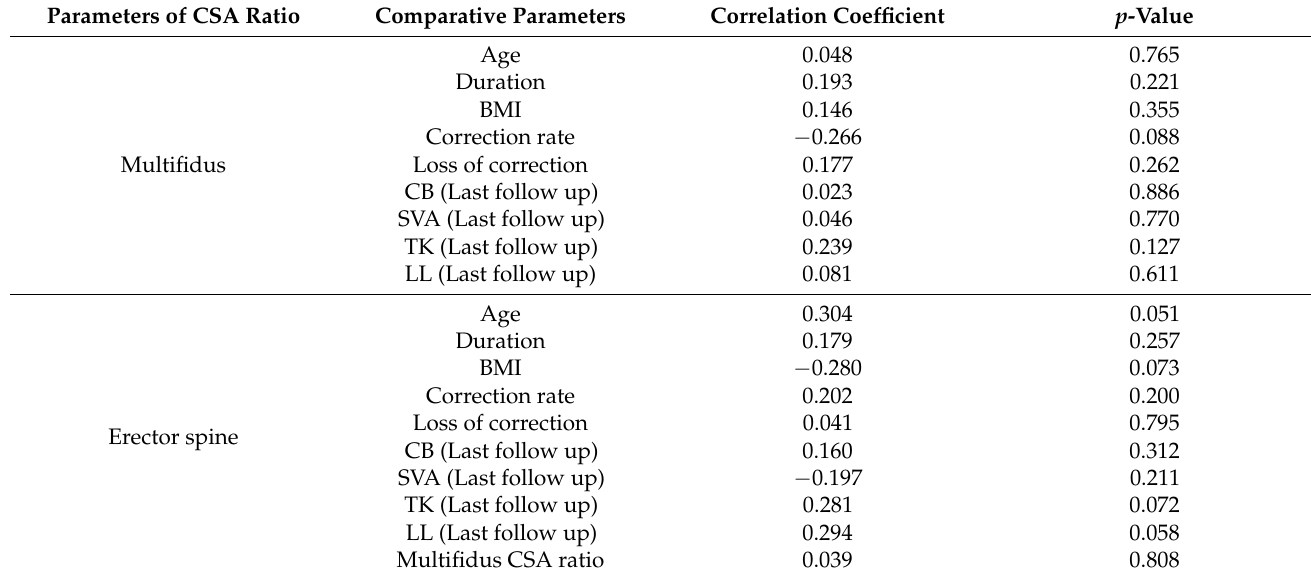
Table 4. Pearson’s correlation analysis between last-follow-up paraspinal muscle and the measured parameters. Parameters of CSA Ratio Comparative Parameters Correlation Coefficient p -Value